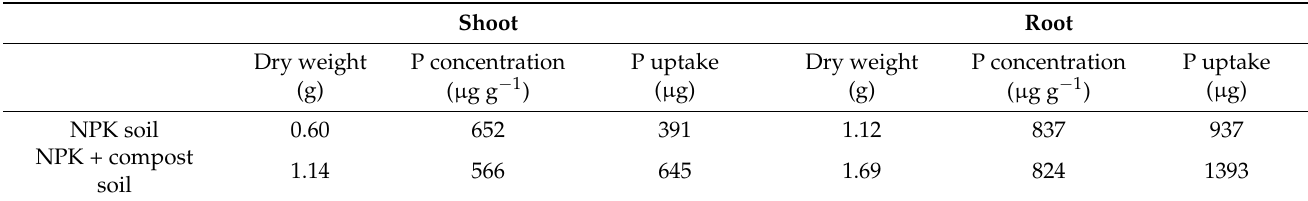
Table 2. Dry weight and concentration and uptake of phosphorus in shoots and roots of seven barley seedlings. Shoot Root Dry